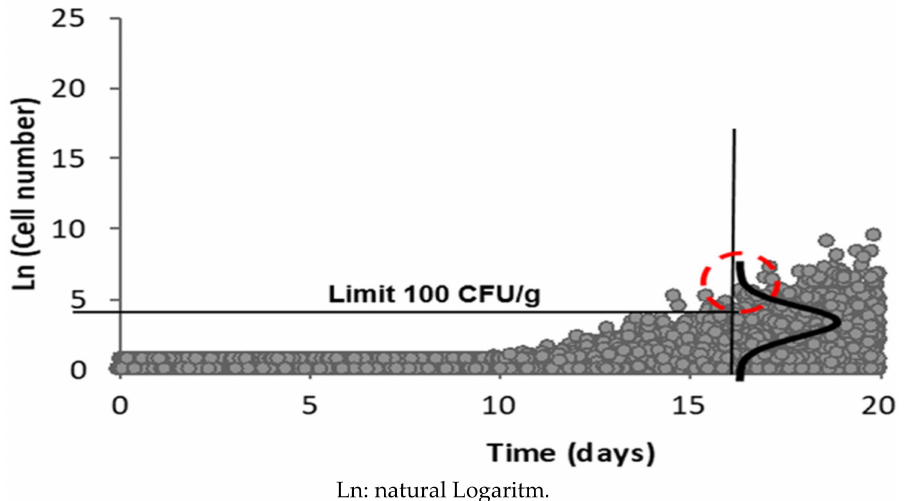
Figure 4. Estimation of the non-compliance of the regulation limit of 100 CFU / g established in the Chilean Food Sanitary Regulations. A total of 39% of ready-to-eat cooked meat products can exceed the Listeria monocytogenes limits at the end of their 16-day